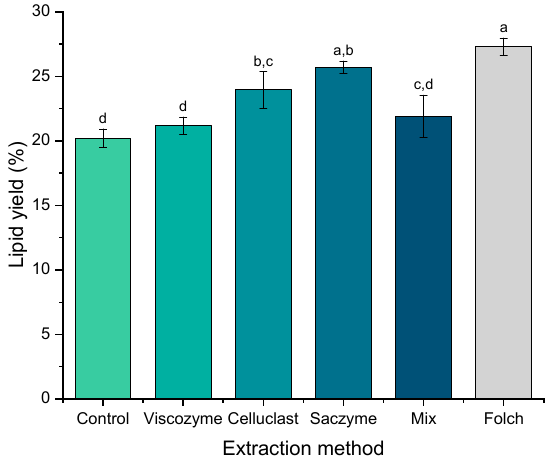
Figure 2. Lipid extraction yield using enzyme-based alternatives with different commercial enzymatic solutions: Viscozyme ® L, Celluclast ® 1.5 L, Saczyme ® Yield, and a mix of the enzymatic solutions (1:1:1 v / v ). A control assay was done without enzymatic solution (control). Results are expressed as a percentage of dry weight. Error bars denote the standard deviation of three independent extractions (n = 3). Different letter indicates statistically significant differences at p < 0.05 (one-way ANOVA with post-hoc Tukey, a–d).